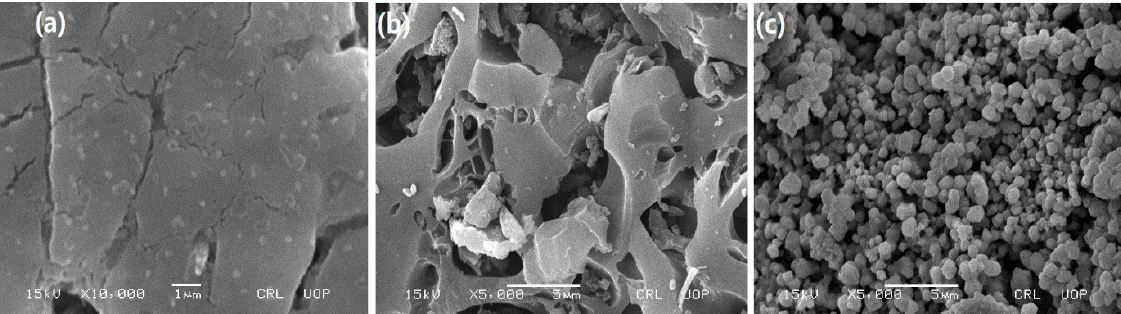
Figure 1. SEM image of ( a ) PS, ( b ) CPS, and ( c )